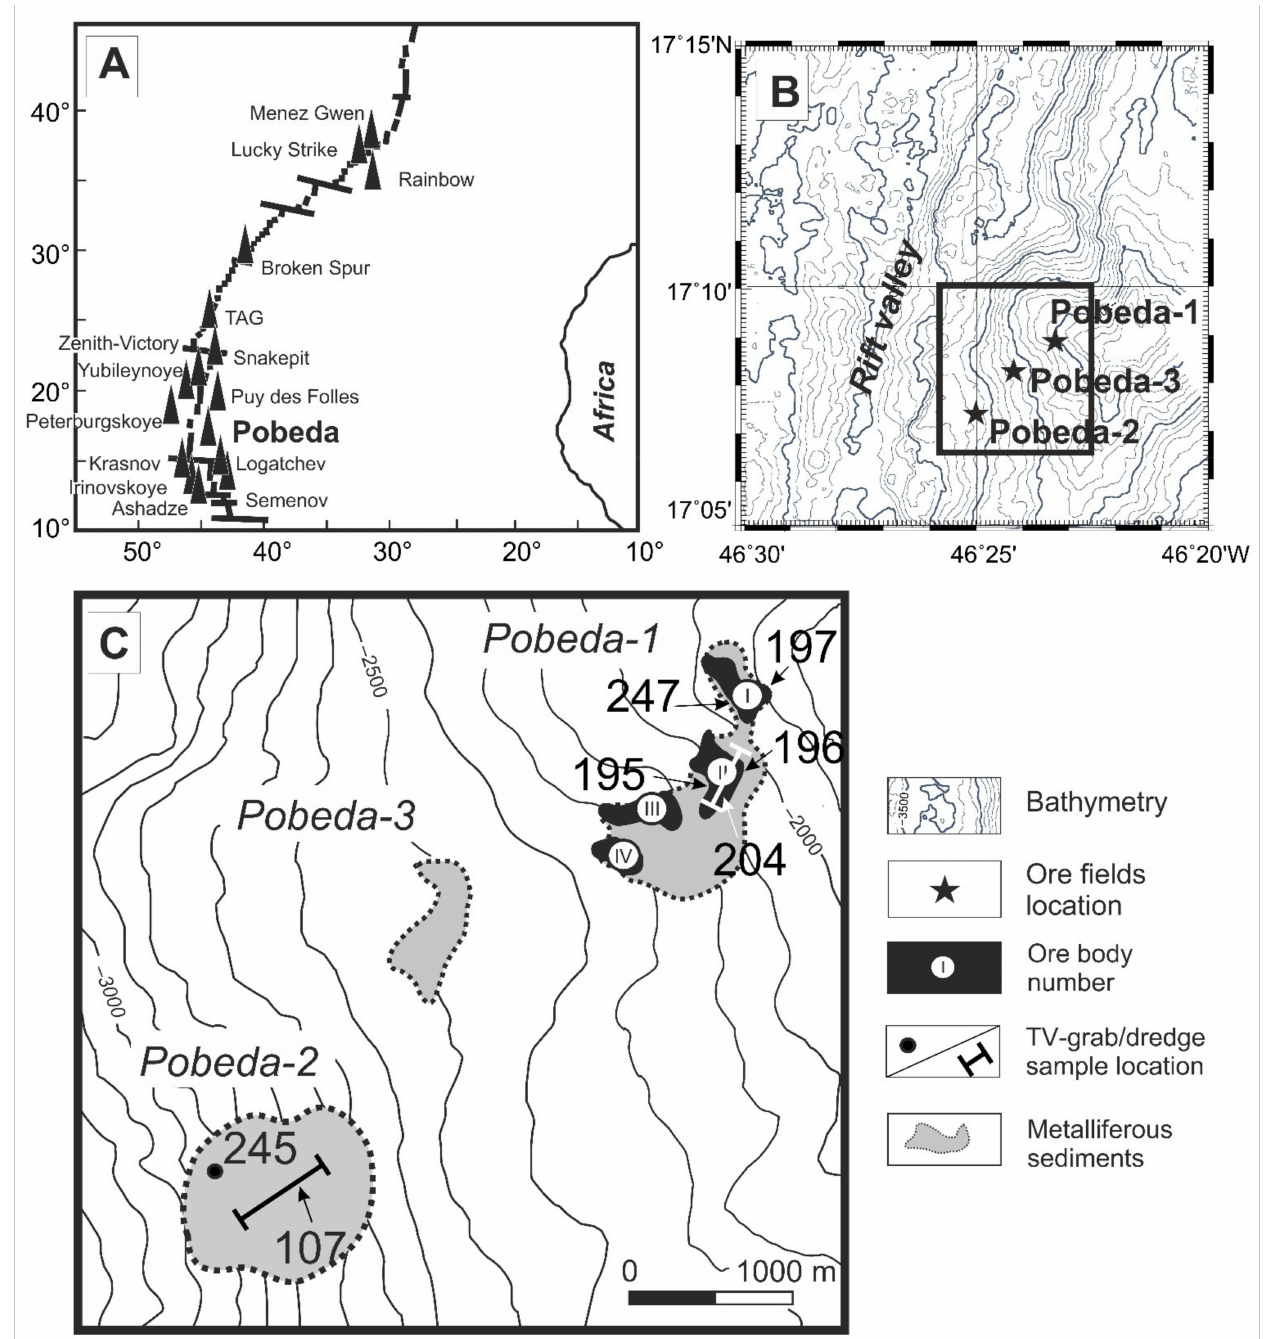
Figure 1. Geological setting of the Pobeda massive sulfide hydrothermal fields. ( A ) Location of the Pobeda cluster at the Mid-Atlantic Ridge; ( B ) Position of the Pobeda-1, 2 and 3 hydrothermal fields at the Mid-Atlantic Ridge bathymetry; ( C ) Detailed scheme of hydrothermal fields with location of sampling stations